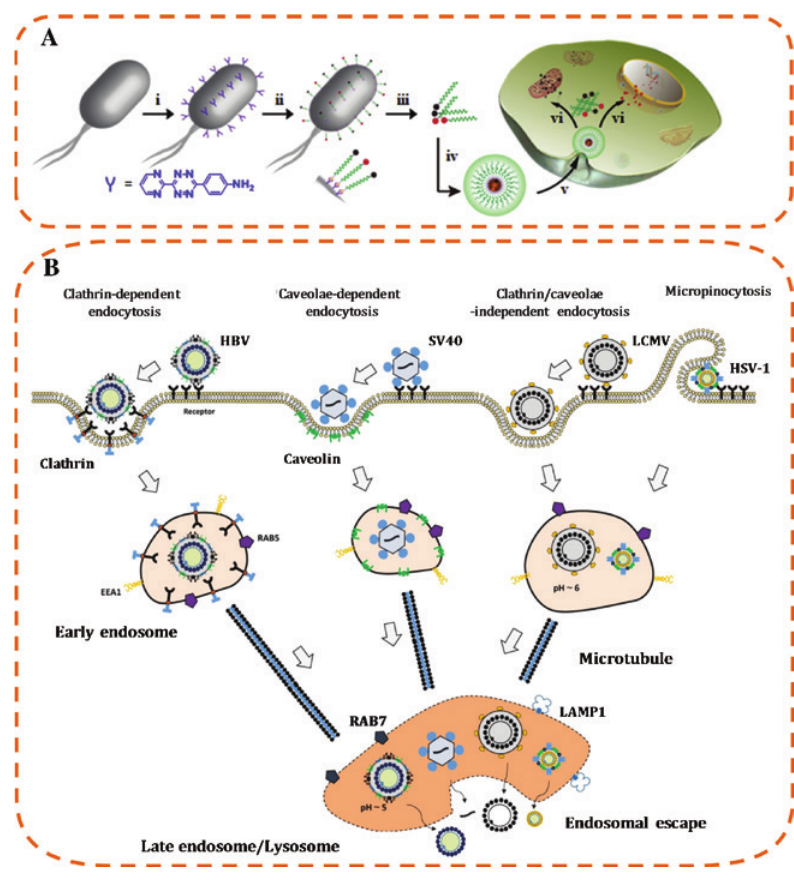
Figure 14: Drug delivery using light-sensitive bacteria and viruses. (A) Schematic diagram of the bacterial microbots to load, deliver, and release active drugs for cancer therapy. (B) Cellular